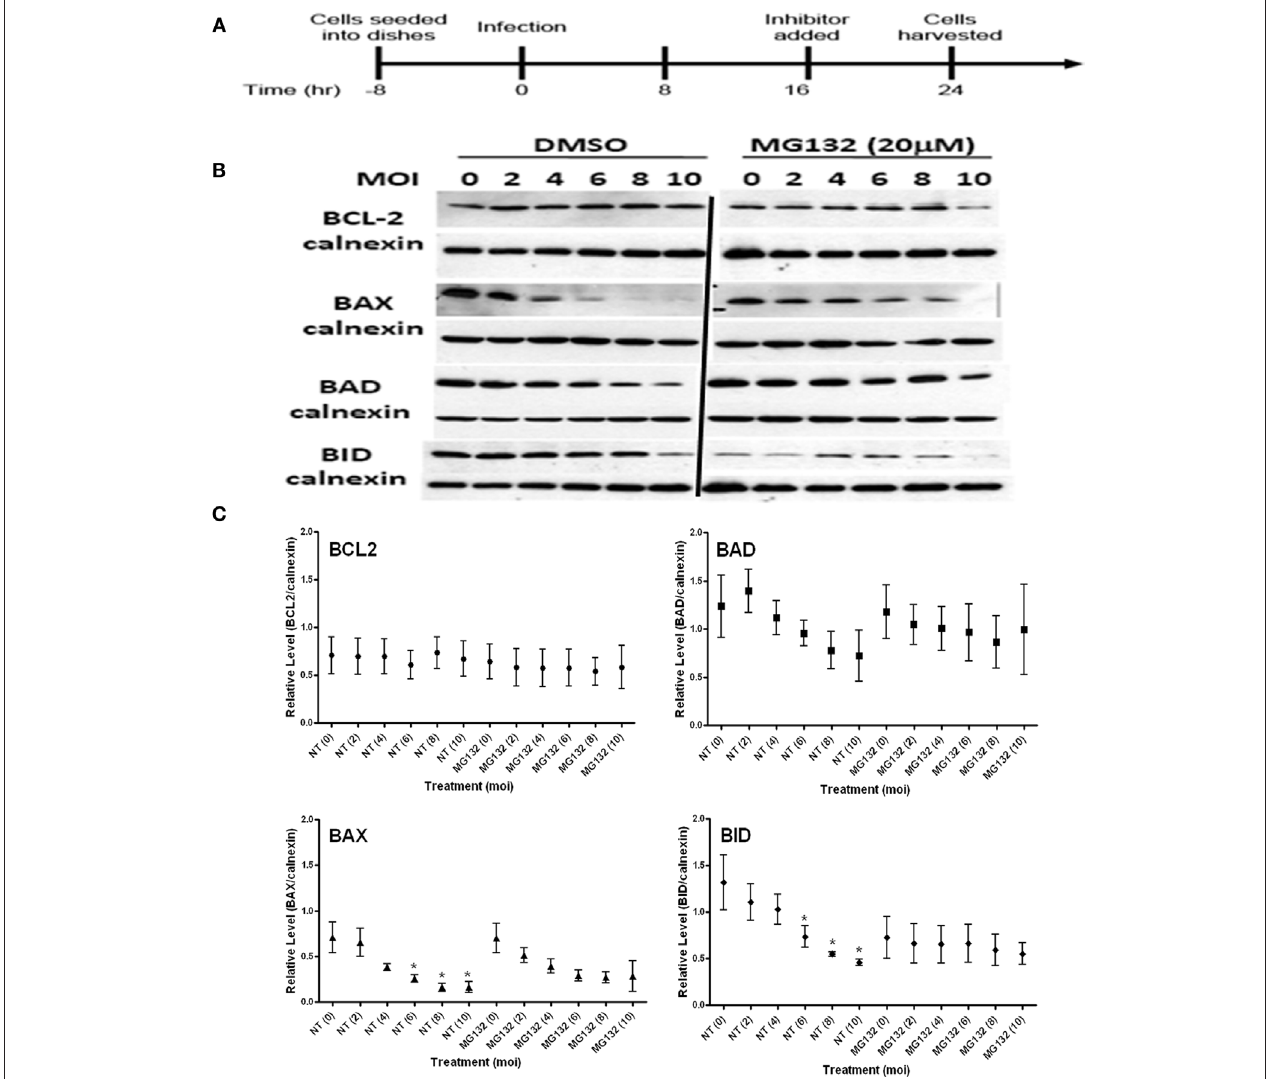
Figure 3 | effect of proteasome inhibition with Mg132 on the steady state levels of BCL2-family proteins in both uninfected (MOi = 0) and infected (MOi 2–10) cells. (A) Experimental strategy for the establishment of infection and treatment with the inhibitor. (B) Representative immunoblots detecting the levels of the indicated BCL2-family members in response to increasing infection. Levels of calnexin are used as a loading control. (C) Quantification of the levels of specific BCL2-proteins relative to calnexin in response to increasing infecting